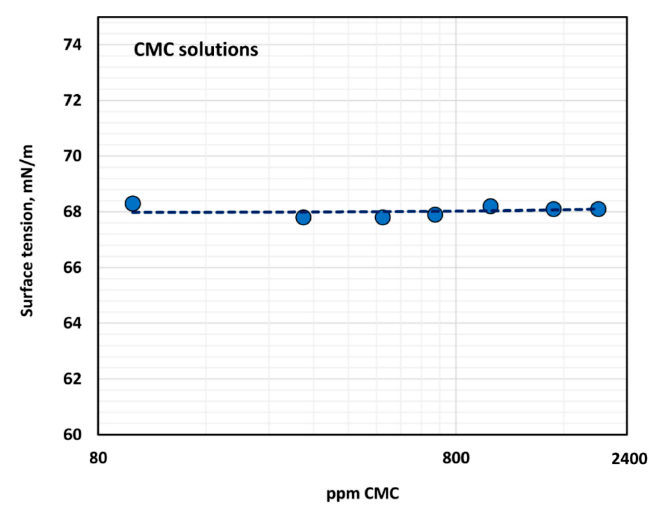
Figure 4. Variation of surface tension of polymer solution with the increase in polymer concentration.